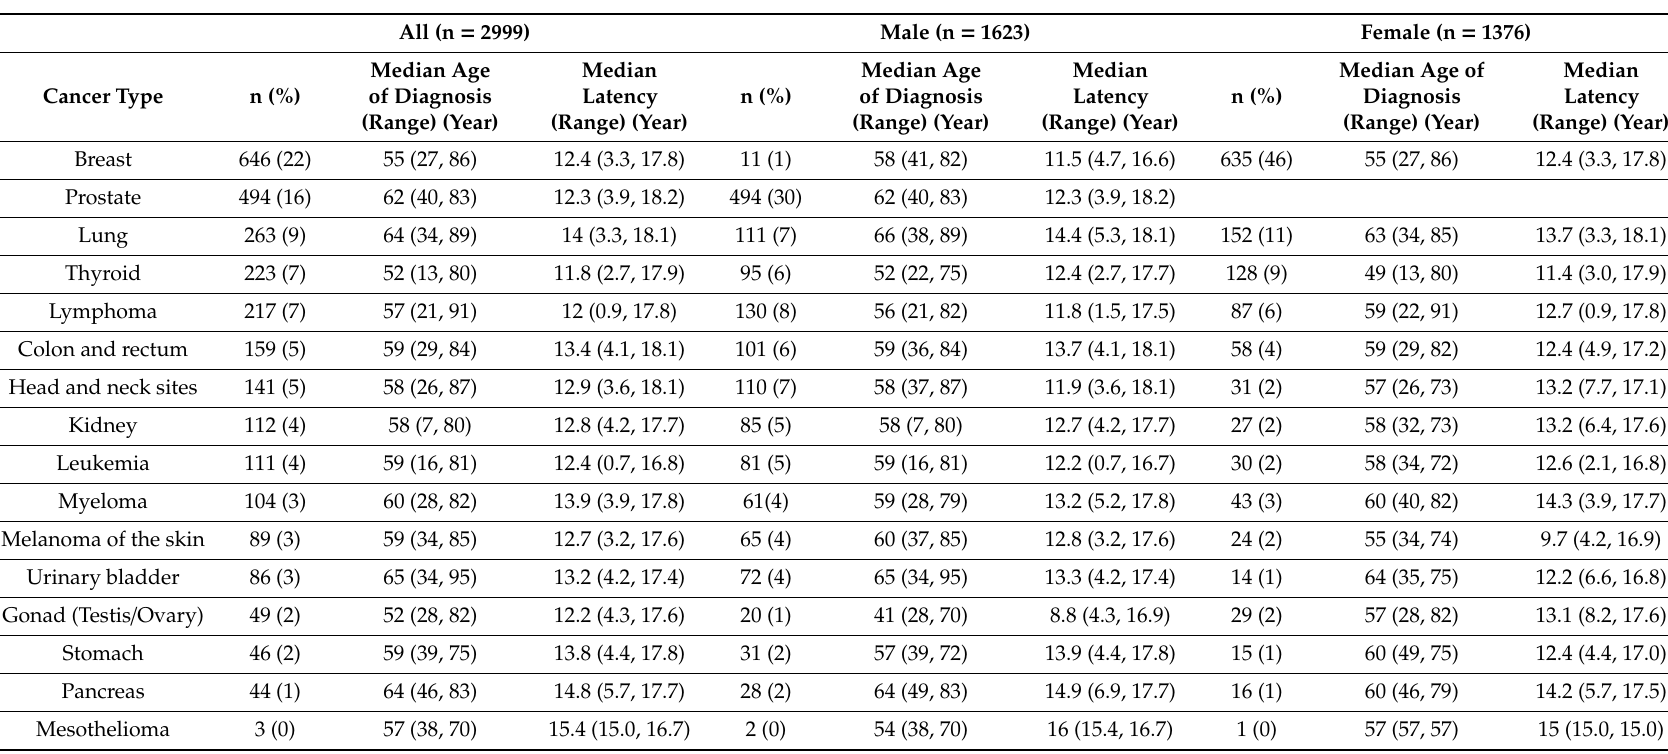
Table 3. The median age of diagnosis and median latency in years from 9 / 11 distribution for top fifteen cancer and mesothelioma in male and female in the WTC